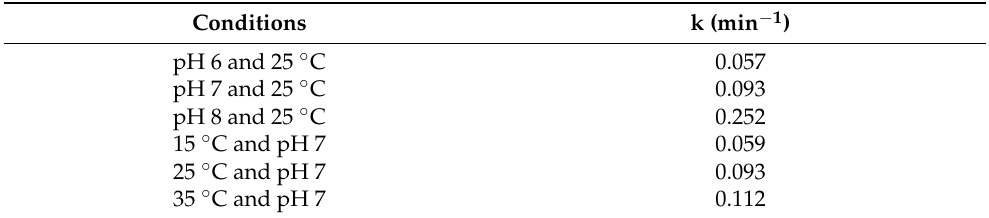
Table 1. First-order kinetic constants of ozone decomposition under different experimental conditions using zeolite T as catalyst.